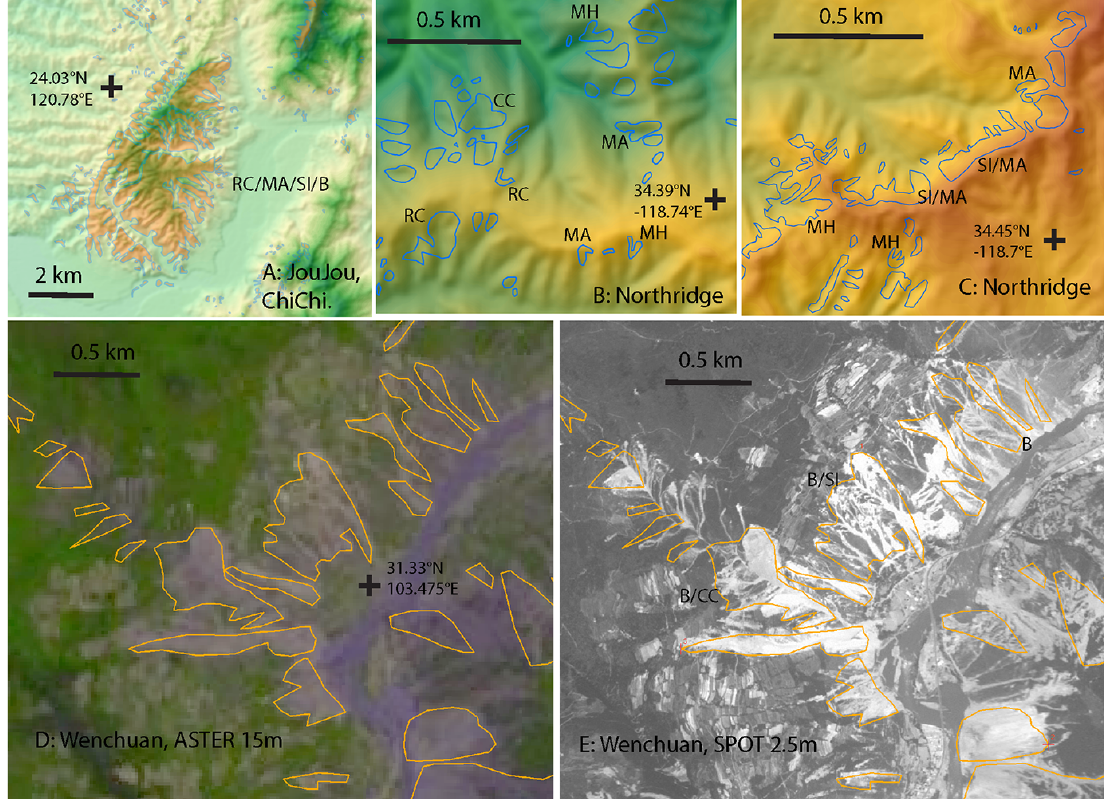
Figure 2. (a) , (b) , (c) : landslide polygons on a DEM topography showing examples of amalgamation in the ChiChi and Northridge inven- tories. Geometric and topographic inconsistencies that signal amalgamation are specified as follows: RC for ridge crossing, CC for channel crossing, MH for multi-headed, MA for multi-armed and SI for slope inconsistencies. (d) , (e) : some polygons mapped by Gorum et al. (2011) after the Wenchuan earthquake overlaid on a 15m resolution ASTER image (d) and on a 2.5m resolution SPOT 5 image (e) of the same area. Note the presence of amalgamation but also the significant mapping extent exaggeration when mapping on low resolution relative to the landslide